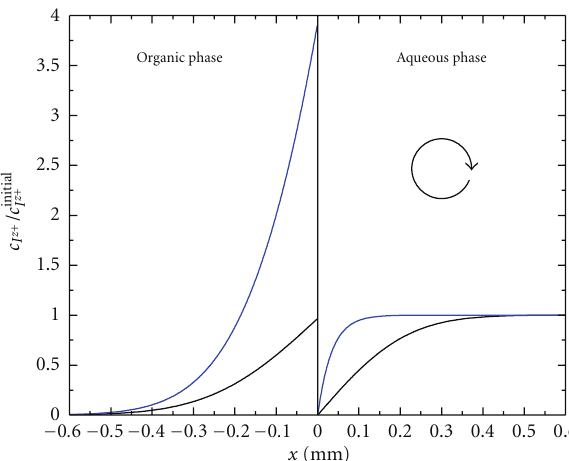
Figure 4: Concentration profiles obtained at switching time, λ . Quiescent solution (black line) with forced hydrodynamic condi- tion applied in aqueous phase, ν W x = 3 × 10 − 3 cms − 1 (blue line). Other parameters are as in Figure